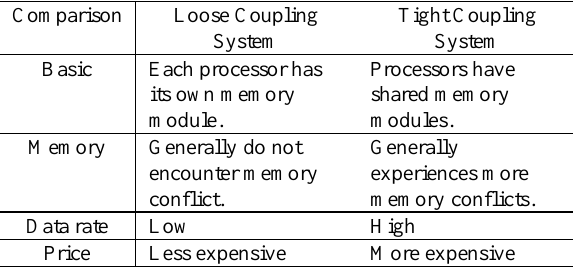
The visual-based integrated navigation system overview is Table 1. Comparison between Loose Coupling and Tight shown in Figure 9. The output of visual-based navigation Coupling (Tech Differences, 2017) algorithms is low frequency absolute camera state. At the same time, the inertial navigation requires the simulated IMU data to generate high frequency relative position and attitude of the camera as its output. These output states will eventually become the input of KF, and the final absolute camera state result is obtained.